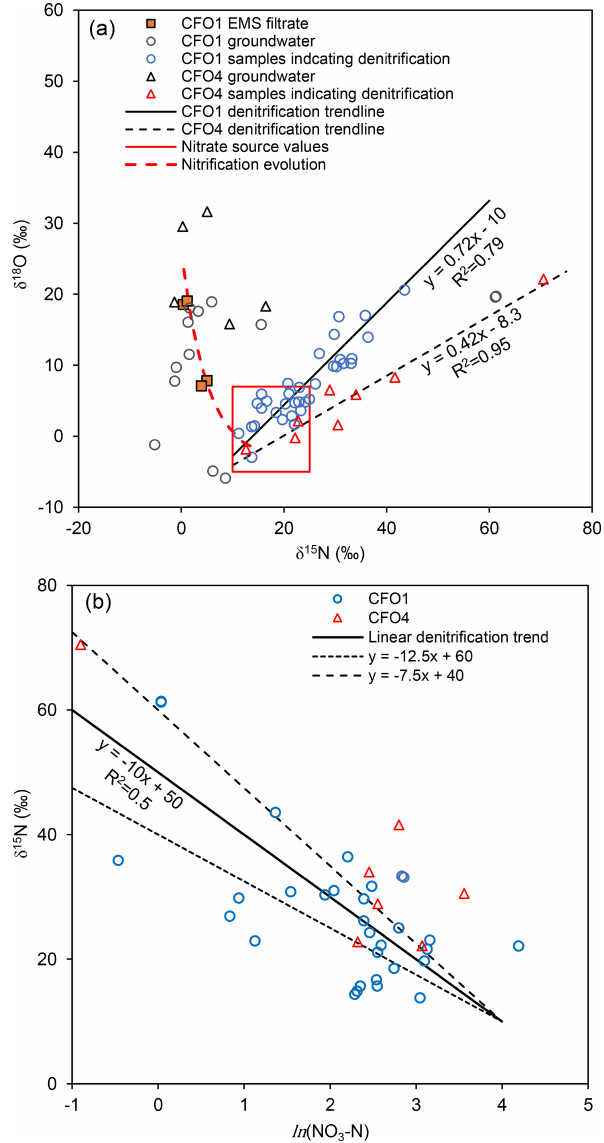
Figure 2. (a) Cross-plot of stable isotopes of nitrate at CFO1 and CFO4 showing hypothetical nitrification trend, boundary of manure-sourced NO − values and linear enrichment trends associ- 3 ated with denitrification. (b) Enrichment of δ 15 N NO during deni- 3 trification (only samples within source region and with evidence of denitrification are shown); dashed lines represent ± 1SD of enrich- ment factor ( ε = −